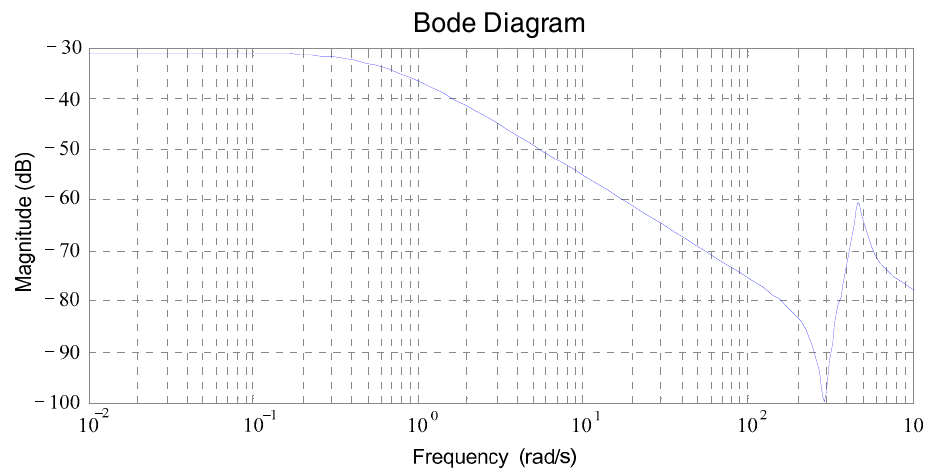
θ  feedback. w . θ  feedback. θ w feedback. w